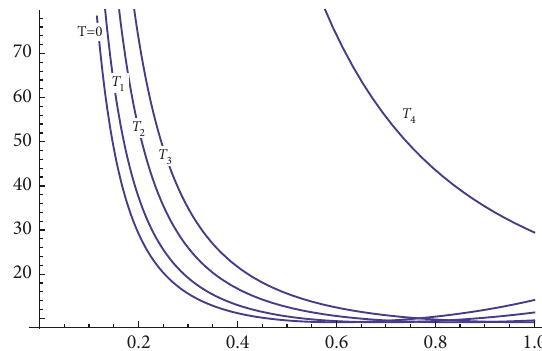
Figure 1: A plot of a potential 𝑉 𝑐 (𝑟, 𝑇) against 𝑟 for different temperatures.